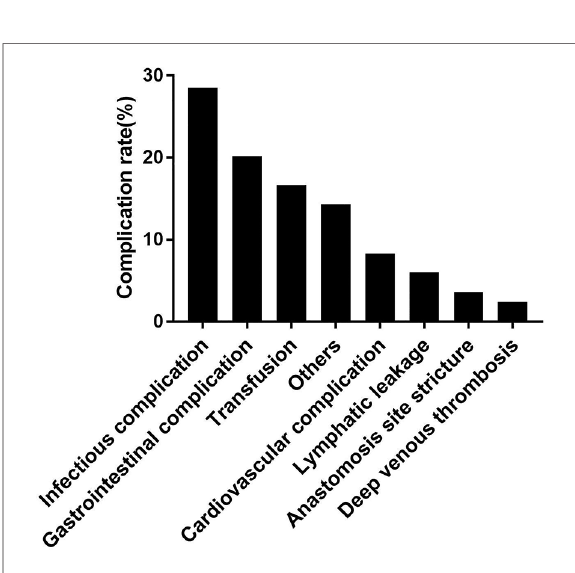
FIGURE 2 Type of early complications after RARC and urinary diversion.